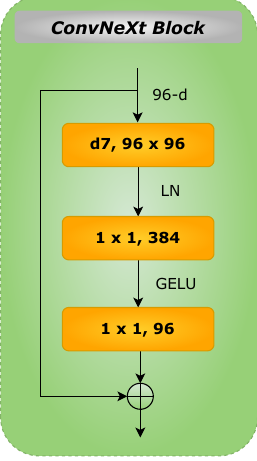
Figure 4. Schematic diagram of ConvNeXt